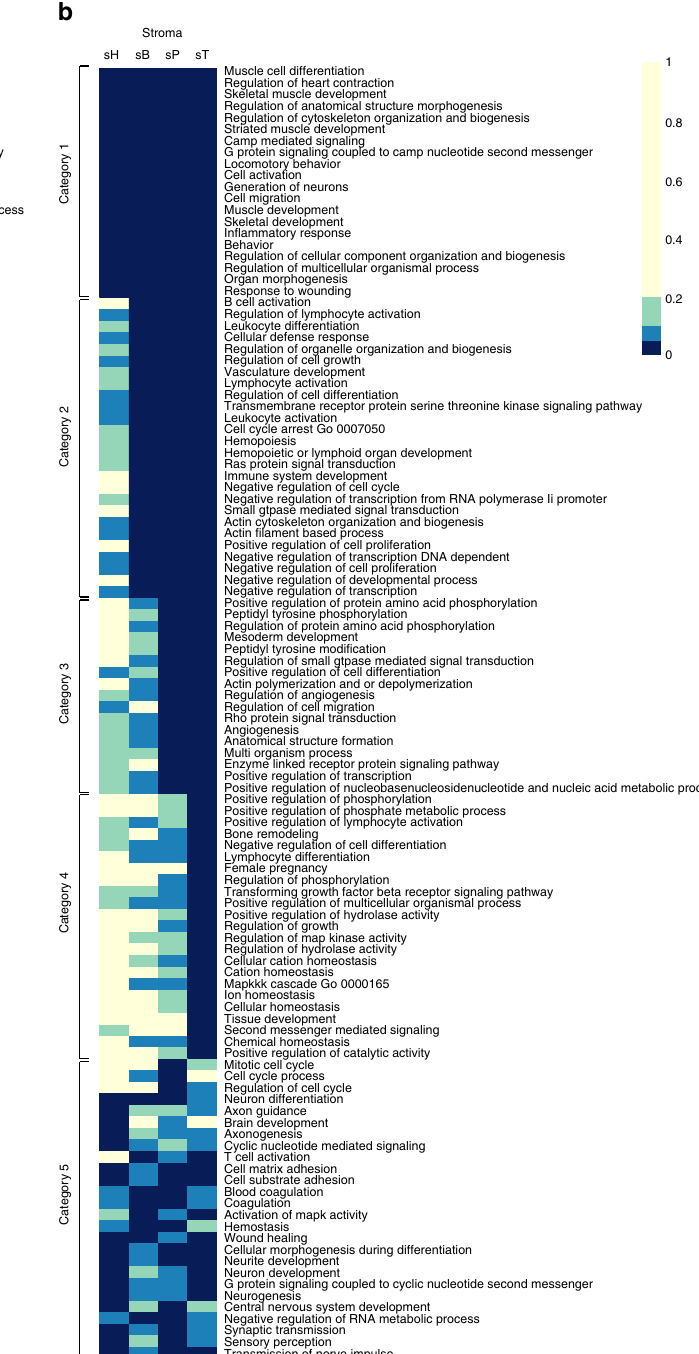
Fig. 1 Heatmaps of the GO biological processes enriched in a epithelial and b stromal compartments across healthy prostate tissues and stages of prostate cancer progression. The cells in the heatmaps are colored according to the FDR of the process in the gene set analysis. Dark blue color corresponds to signi fi cance at 0.05 level and yellow to FDR > 0.2. Categories across compartments show conserved to unique processes from H to B to P to T. Most relevant pathways are summarized in categories: Category 1 ( top ) epithelial: amino acid metabolism; Category 2 epithelial: secretory pathway; Category 3 epithelial: RNA synthesis; Category 4 epithelial: RNA, protein, and lipid synthesis; Category 5 epithelial: miscellaneous; Category 1 ( top ) stromal: muscle development and localization; Category 2 stromal: immune regulation, angiogenesis and cell proliferation; Category 3 stromal: signal transduction, cell migration and angiogenesis; Category 4 stromal: TGF beta, signal transduction and bone remodeling; Category 5 stromal: For cystoprostatectomy we studied benign epithelium and adjacent stroma (H.B and H.sB). Cystoprostatectomies were con fi rmed not to harbor prostate cancer foci through review of the entire submitted specimen. Clinicopathological features of the cohort are described in Table 1.